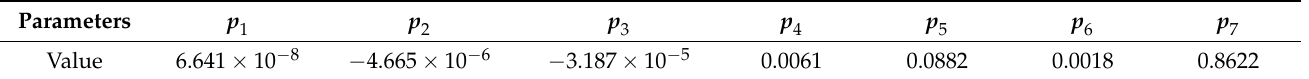
Table 3. Fit results for T B ( I , s , a ) .